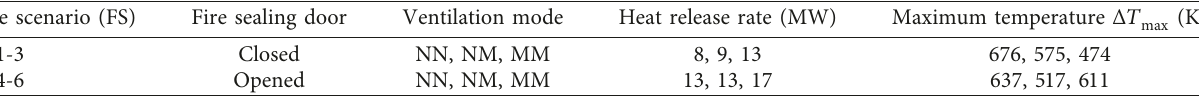
Figure 9: The heat release rate HRR. (a) HRR in FS1-3. (b) HRR in FS4-6. Table 2: Fire scenarios with heat release rate and maximum ceiling